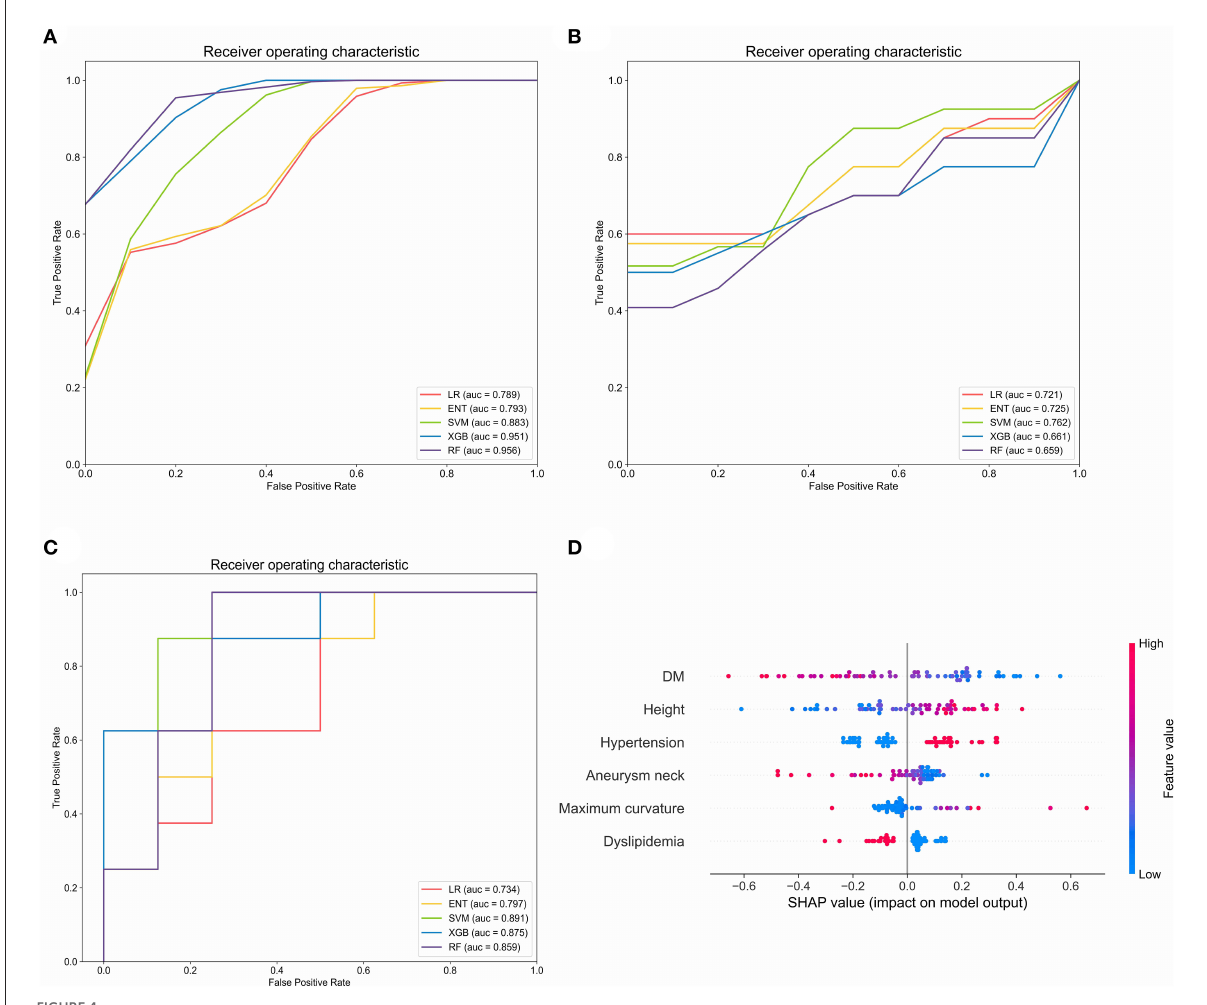
FIGURE4 Evaluation of the machine learning models in the training set, validation set and test set. (A) Comparison of mean area under the receiver operating curve (AUC-ROC) in five prediction models in the training set. (B) Comparison of AUC-ROC in five prediction models in the validation set. (C) Comparison of AUC-ROC in five prediction models in the test set. (D) Feature importance (mean |SHAP value|) of each predictor. LR, Logistic regression; ENT Elastic net regression; Xgb, Xgboost; RF, random forest. The red or blue color of the points represents high or low feature value and the left or right of the X-axis represents positive or negative influence on the model,